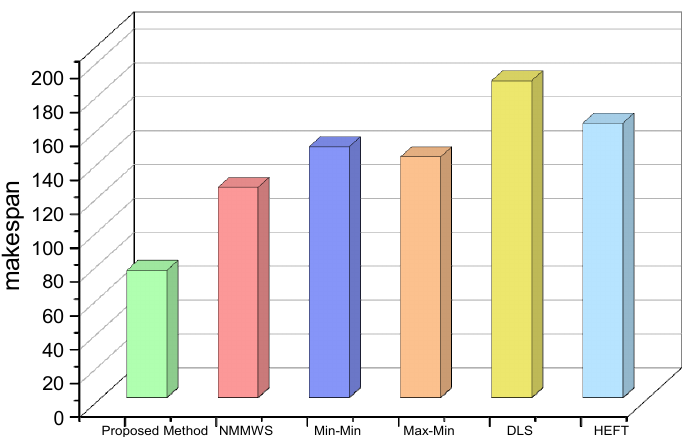
Figure 8. Makespan.